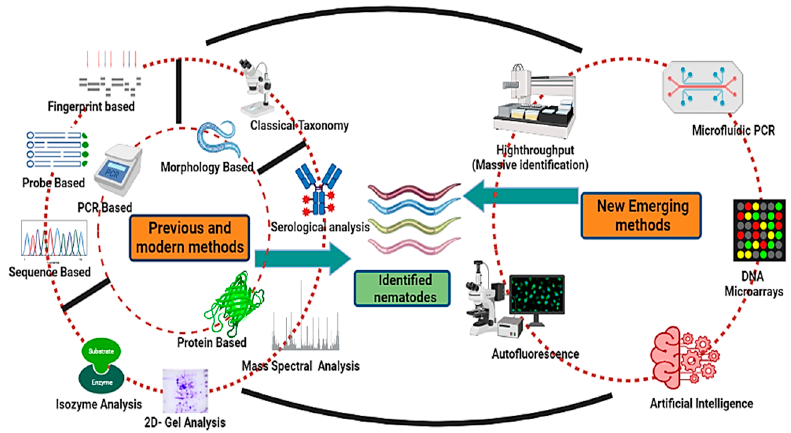
Figure 1. Different nematode identification techniques (previous, advanced, and emerging).